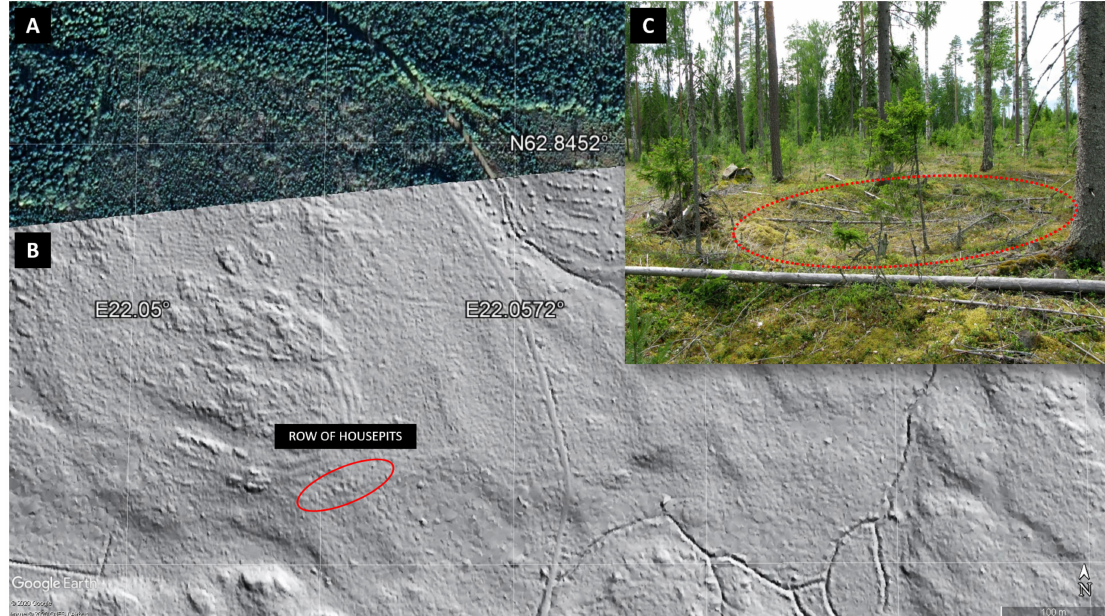
Figure 4. Stone Age housepit features are difficult to find and register via traditional fieldwalking survey in forested environments. They are often detectable in LiDAR generated digital terrain models (DTM) when they occur in clusters of several housepits. ( A ) An aerial photo of thick coniferous forest canopy at Laihia, W Finland; ( B ) 18 housepits and associated pit features in row formation in a LiDAR generated DTM at the Tuoressaari 1 site in Laihia. These features were validated via test pitting and surface find collection; ( C ) an individual housepit is difficult to discern on terrain. Background data provided by Google Earth and the National Land Survey of Finland. Illustration and photo by Satu Koivisto/SKAIK project, Finnish Heritage